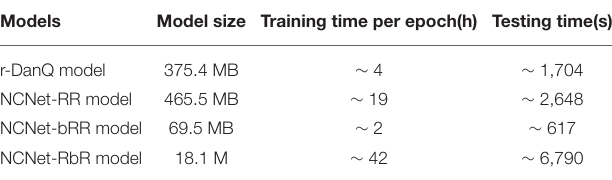
TABLE 3 | Time and Spatial cost of the